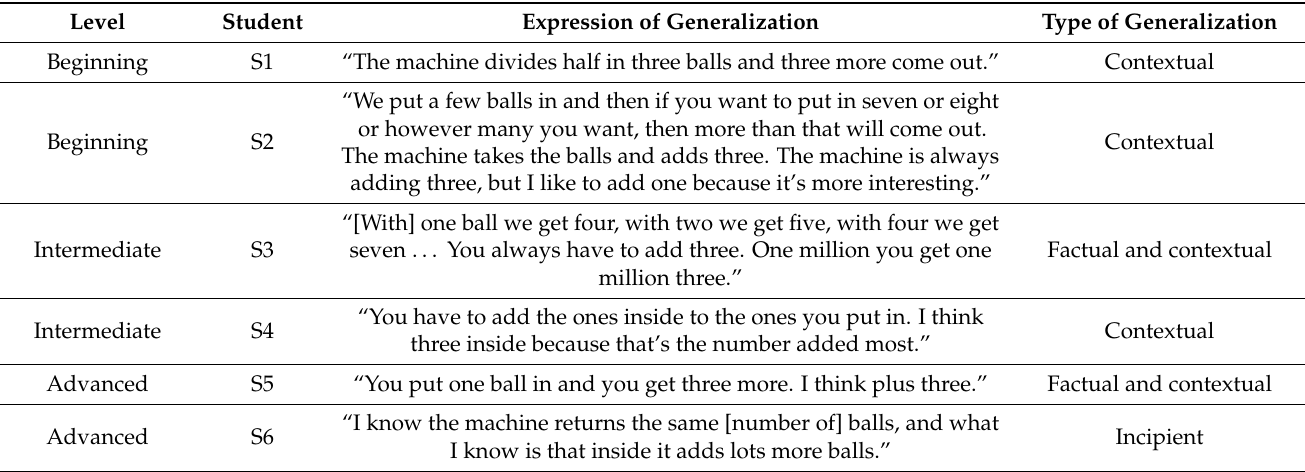
Table 3. Type of